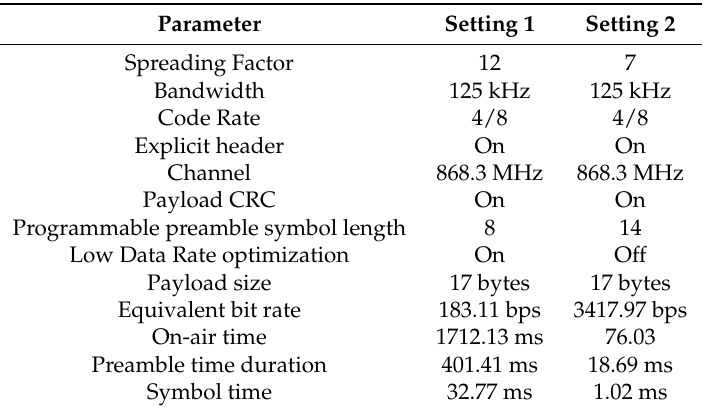
Table 1. Physical layer parameters for the measurement setup.